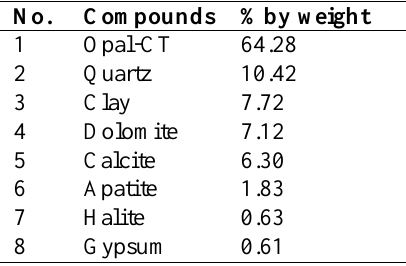
Table 1: The mineral compositions of porcelanite